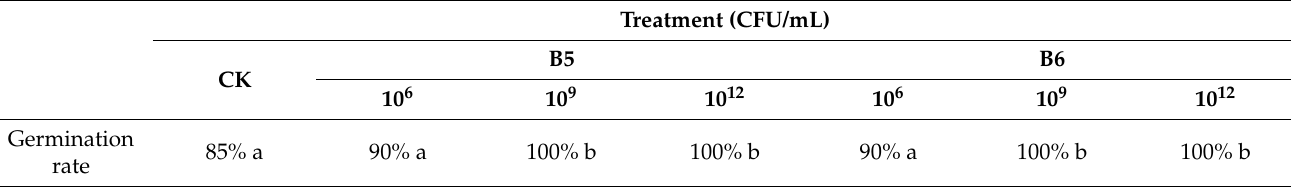
Table 2. Effect of B5 and B6 suspension at different concentrations on cabbage seed